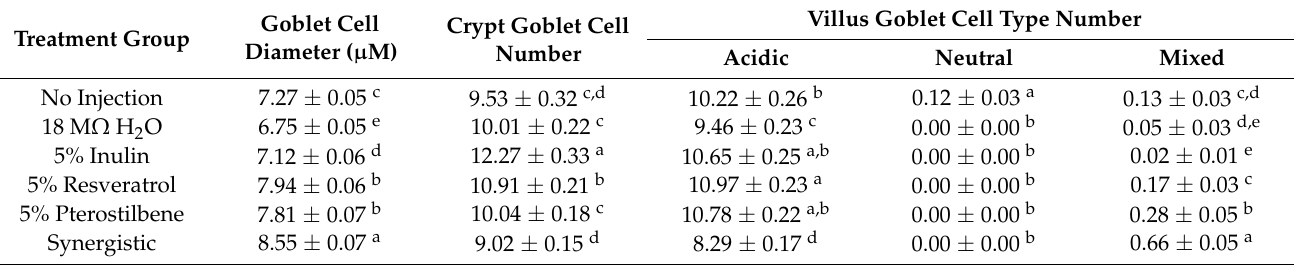
Table 5. Effect of the intra-amniotic administration of stilbenes on the goblet cells of the small